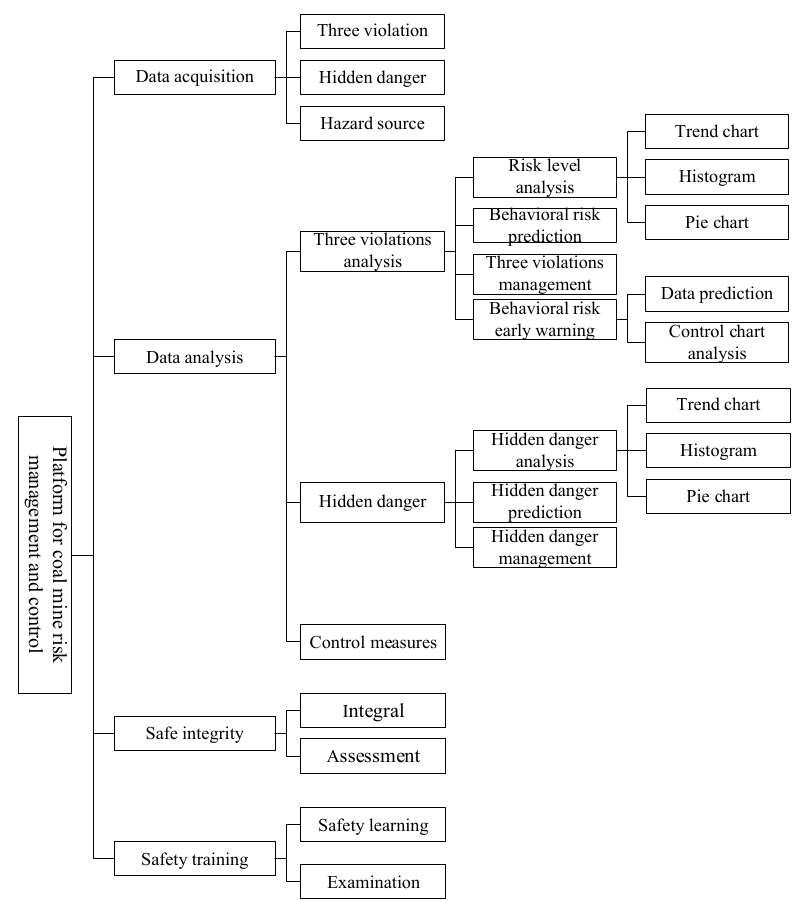
Figure 12. Functional block diagram of the platform. The data analysis module of the control chart was based on the risk prediction model to predict the risk change trend of different levels. It read the corresponding data from the database and calculated the LCL, UCL, and CL according to the requirements of the control chart analysis. The data prediction interface is shown in Figure 13.